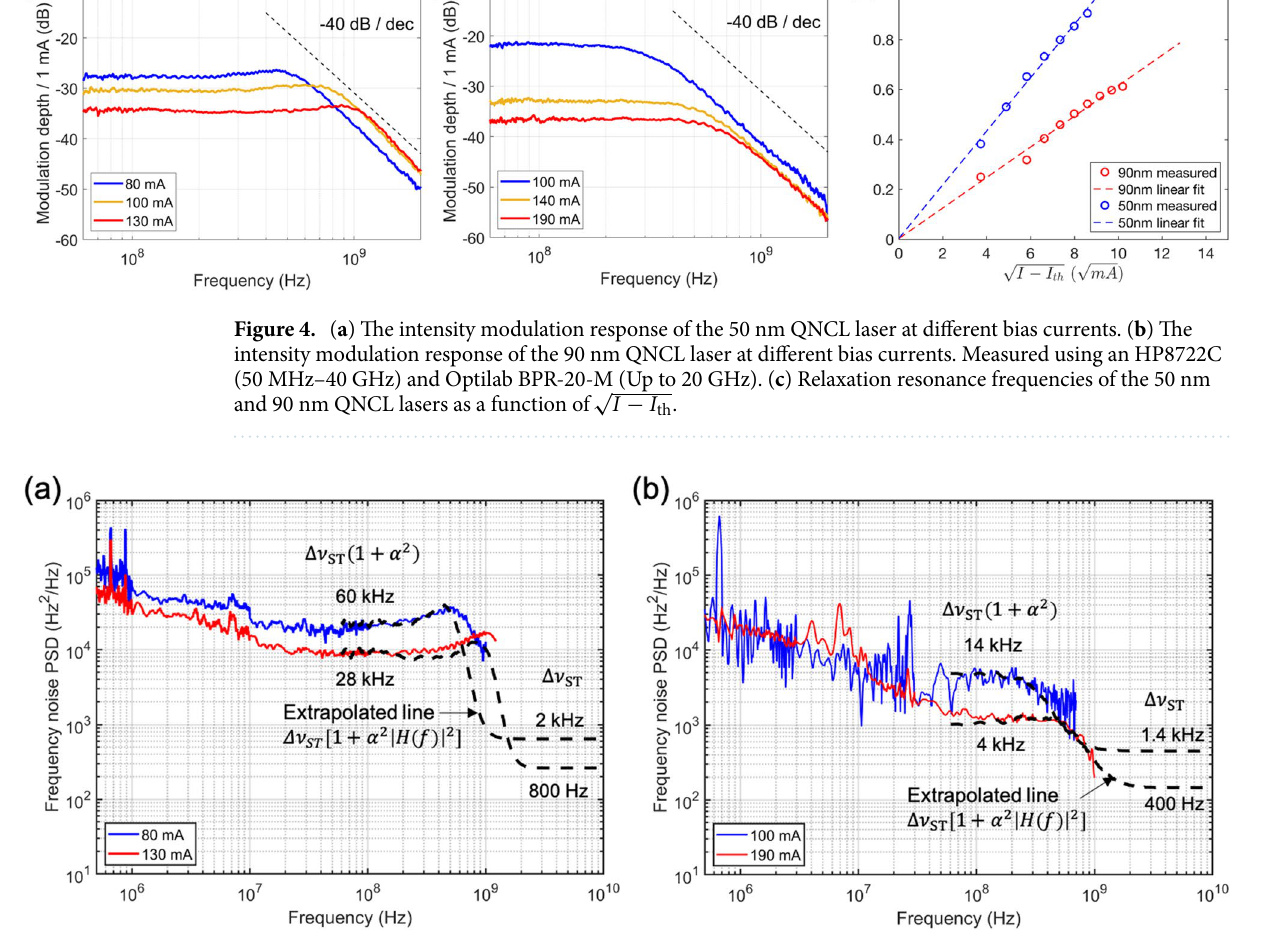
1556nm , α 3.0 80mA , (cid:31) 0 = = =